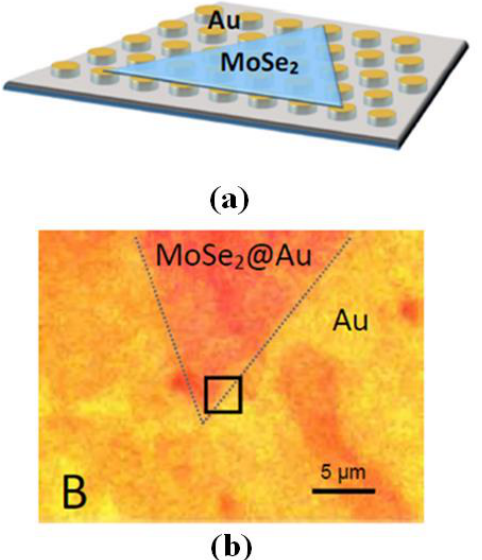
Figure 18. Typical MoSe 2 flake transferred to Au nanodisk arrays. ( a ) Schematic showing the MoSe 2 monolayer coated on top of the Au nanodisk array on a SiO 2 substrate. ( b ) Bright field optical microscopy image (50 × magnification) of MoSe 2 monolayer transferred to Au nanodisk array and fabricated using the shaped nanosphere lithography process [99].